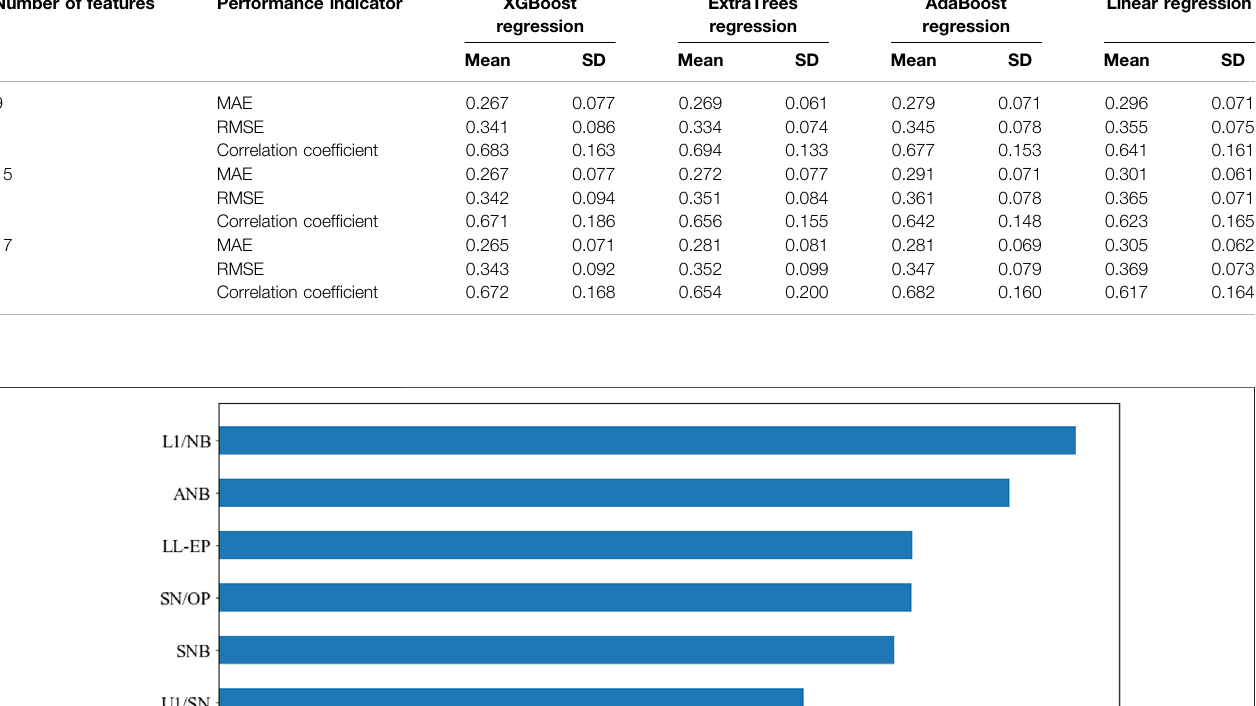
TABLE 3 | Machine learning model performance in the testing set. Number of features